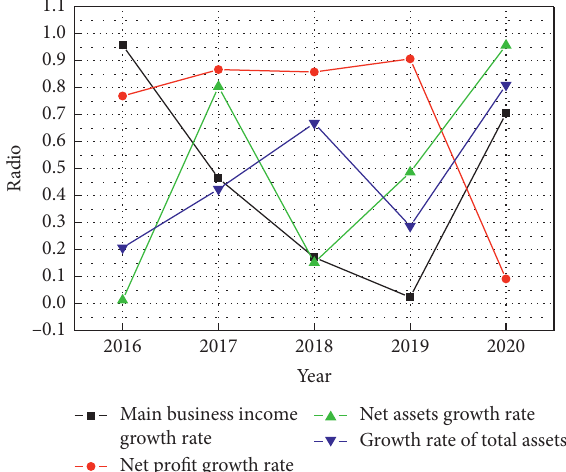
Figure 8: Annual change in the company’s growth capacity in- dicators for